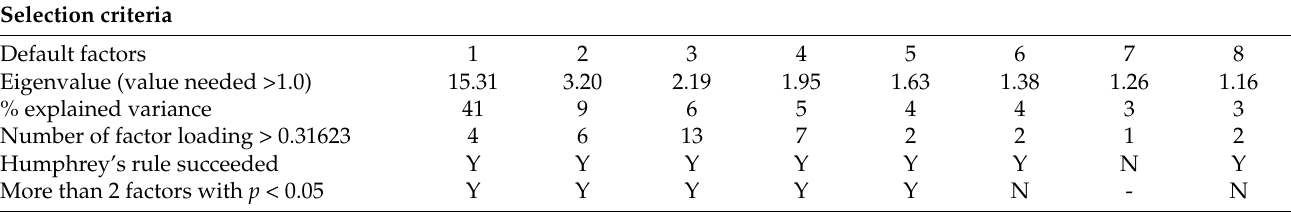
Table 3. Application of selection criteria.